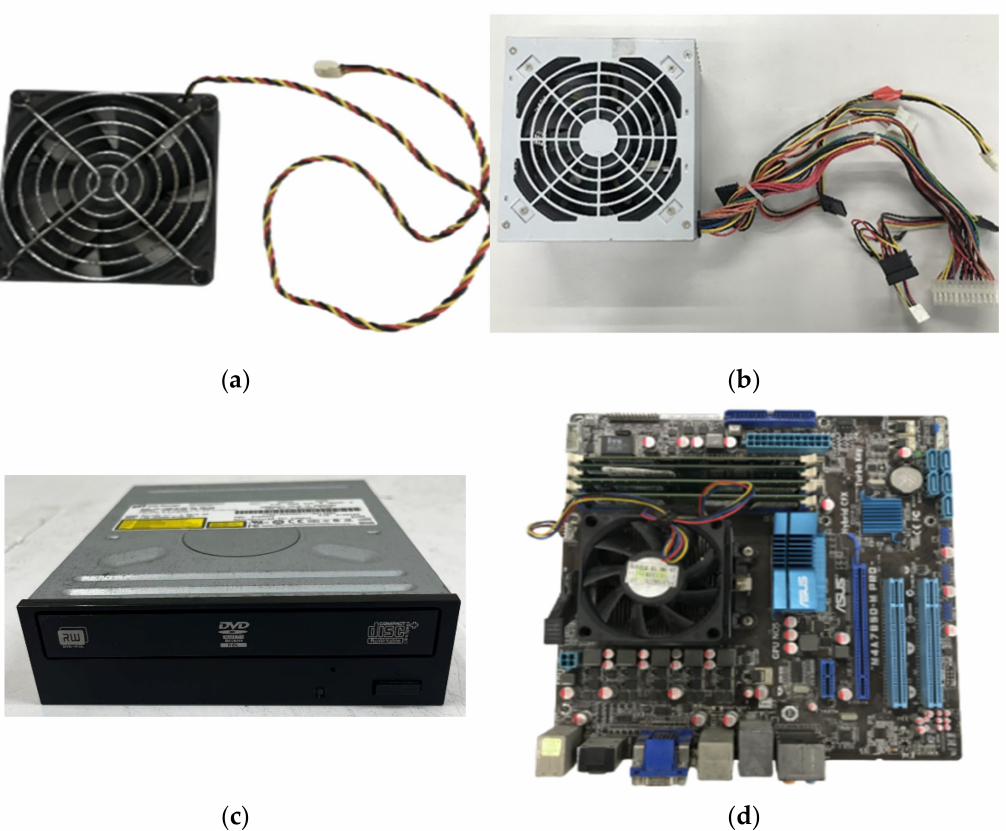
Figure 3. Components in the assembly/disassembly tasks. ( a ) Fan; ( b ) power supply; ( c ) DVD drive; ( d )